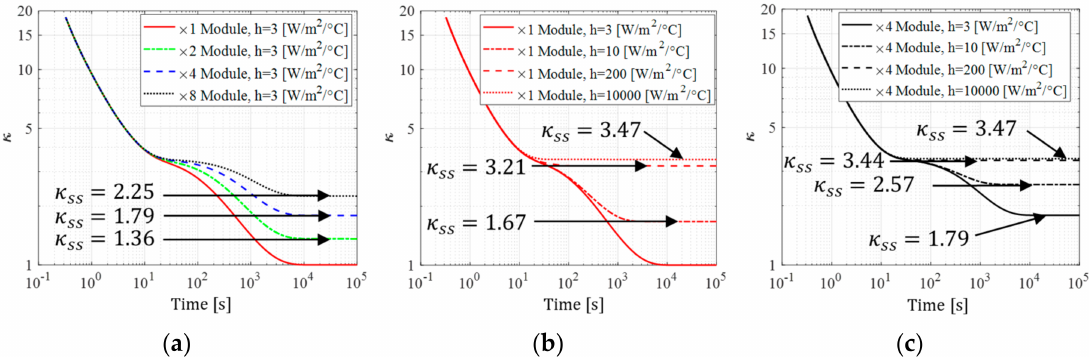
Figure 6. Simulation results of the current amplification ratio κ against sustainable duration with growing ( a ) stacking level; ( b ) heat transfer coefficient in case of unit module; ( c ) heat transfer